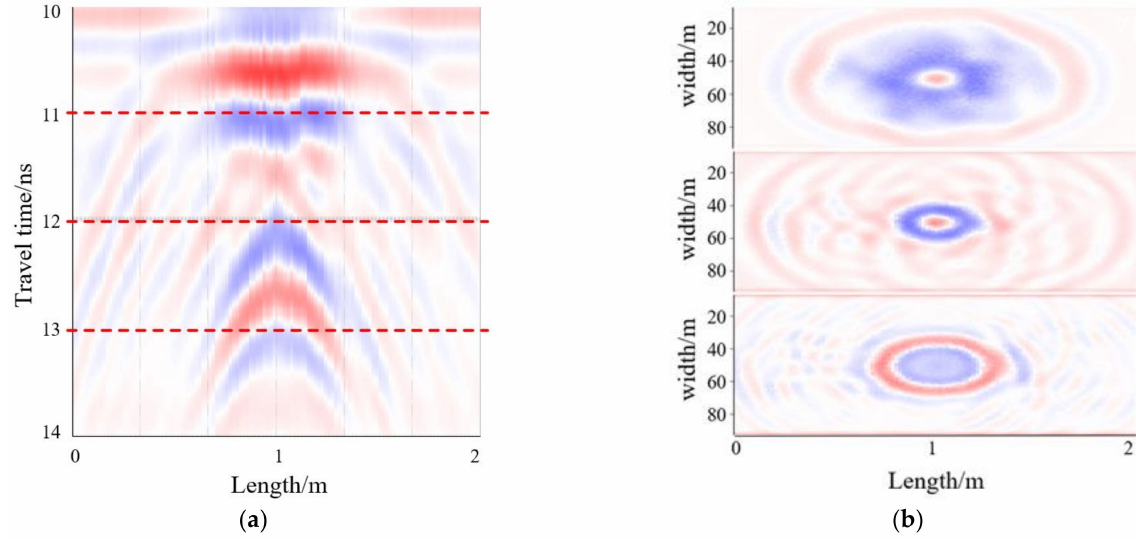
Figure 4. Typical GPR images of an irregular cavity: ( a ) B-scan image; ( b ) C-scan images.